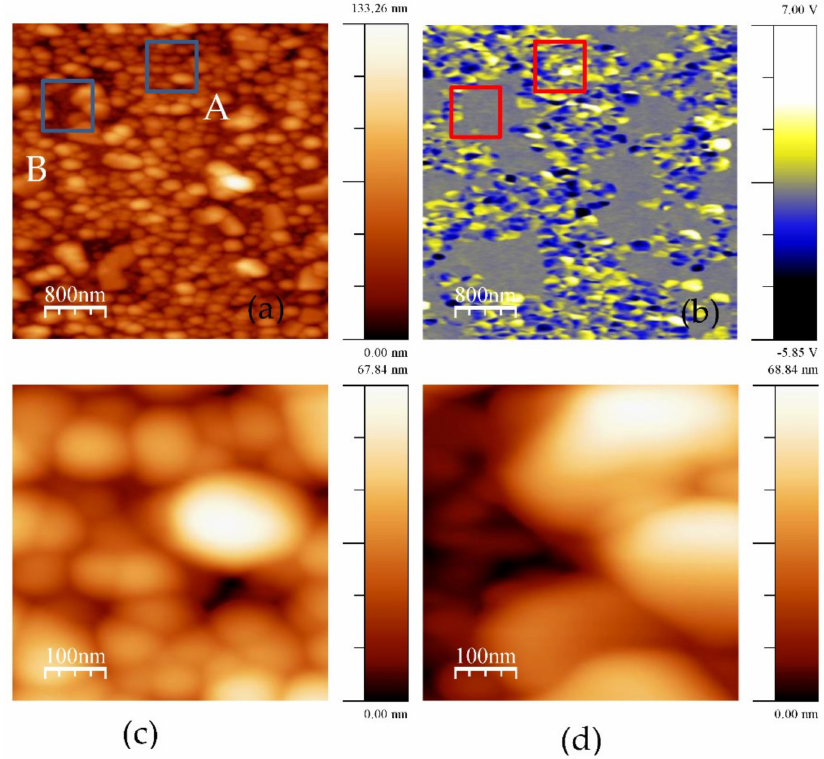
Figure 6. BFO film annealed at 700 ◦ C: ( a ) Topography, ( b ) piezoresponse; and zooms of areas A ( c , d ) shown in Figure 7a. Estimated average grain size of A is 100 nm and B—300